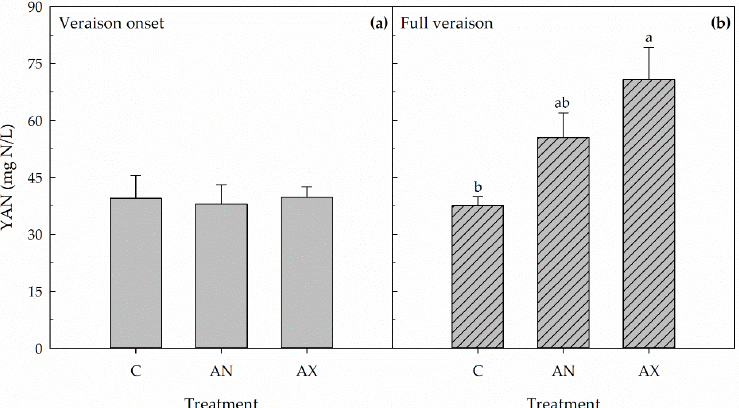
Figure 3. Yeast assimilable nitrogen (YAN) concentration in berries measured at harvest in 2016 in control untreated plants (C) and in vines sprayed at veraison onset ( a ) or full veraison ( b ) with Aminoprotein (AN) or Aminomax (AX). Within each panel, means (n = 8) followed by different letters are significantly different according to Duncan’s test ( p ≤ 0.05).